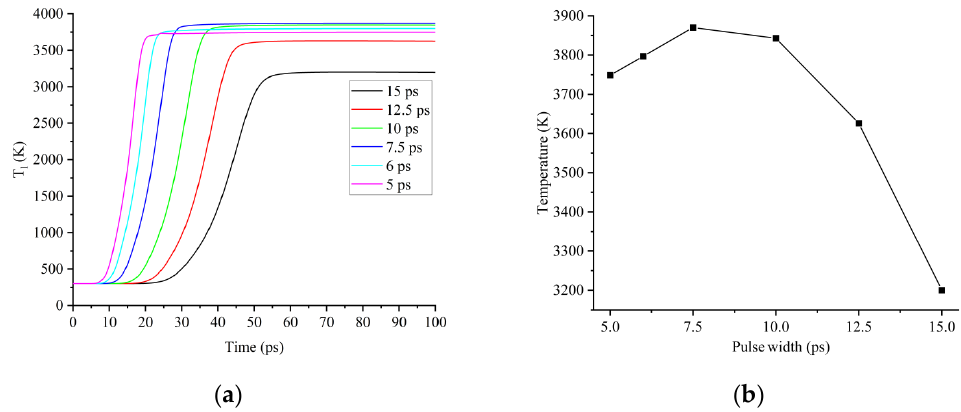
Figure 4. ( a ) Variation characteristic of lattice temperature; ( b ) maximum lattice temperature under the action of picosecond lasers with different pulse widths.